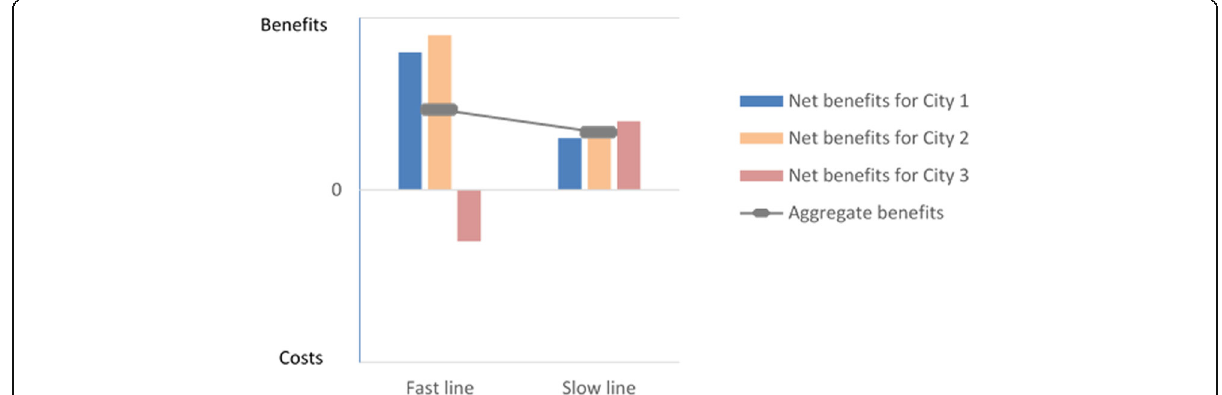
Fig. 2 The socially optimal alternative (fast line) versus the maximin alternative (slow line). Figure by author